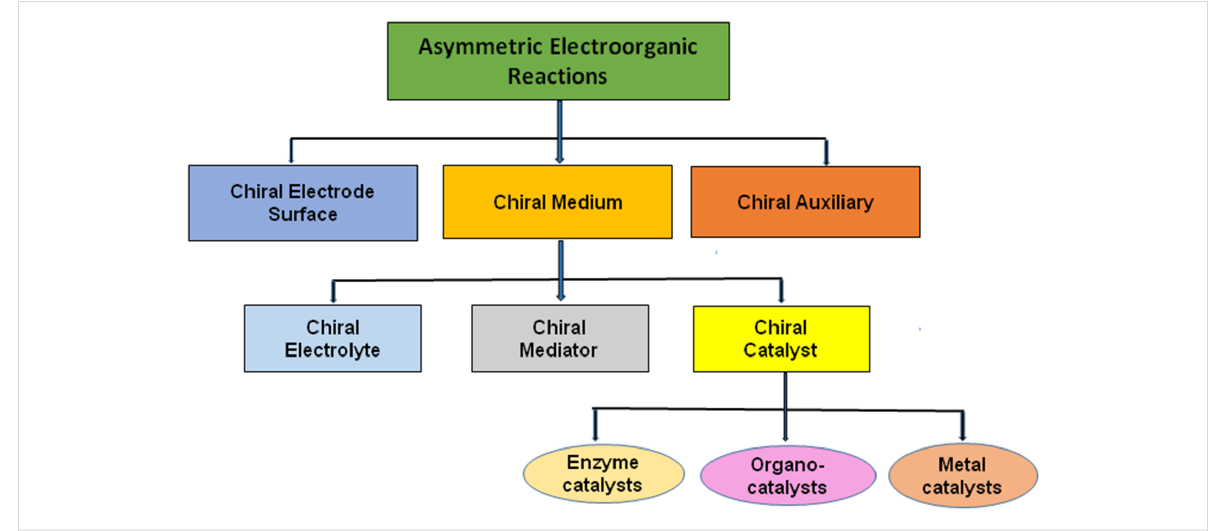
Figure 1: General classification of asymmetric electroorganic